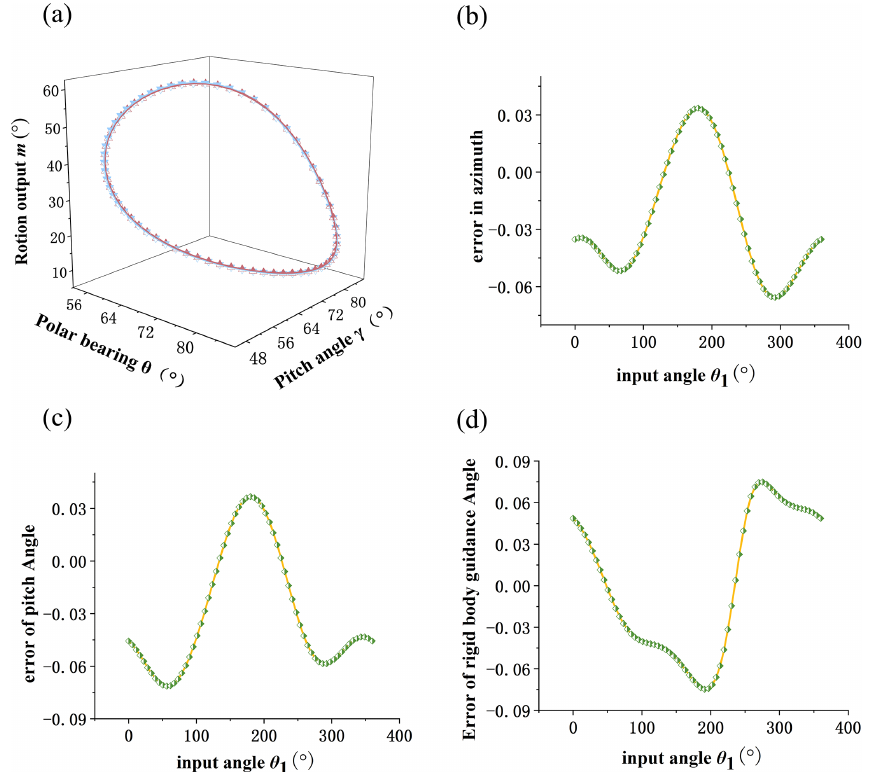
Figure 13. Comparison drawing of the third group of dimensions.